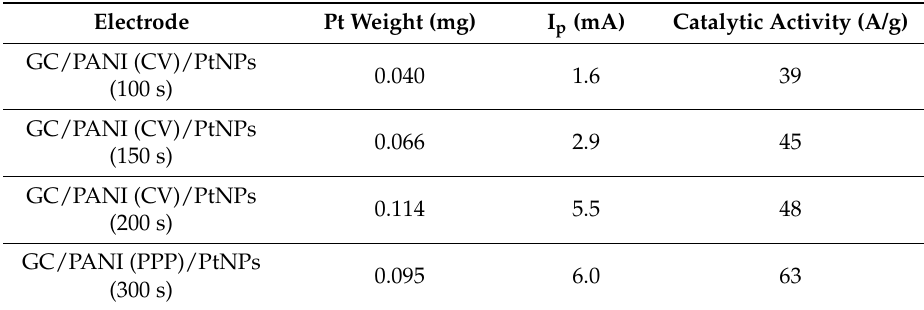
Table 1. The catalytic activity, amount of platinum and current oxidation peak for methanol of different electrodes.